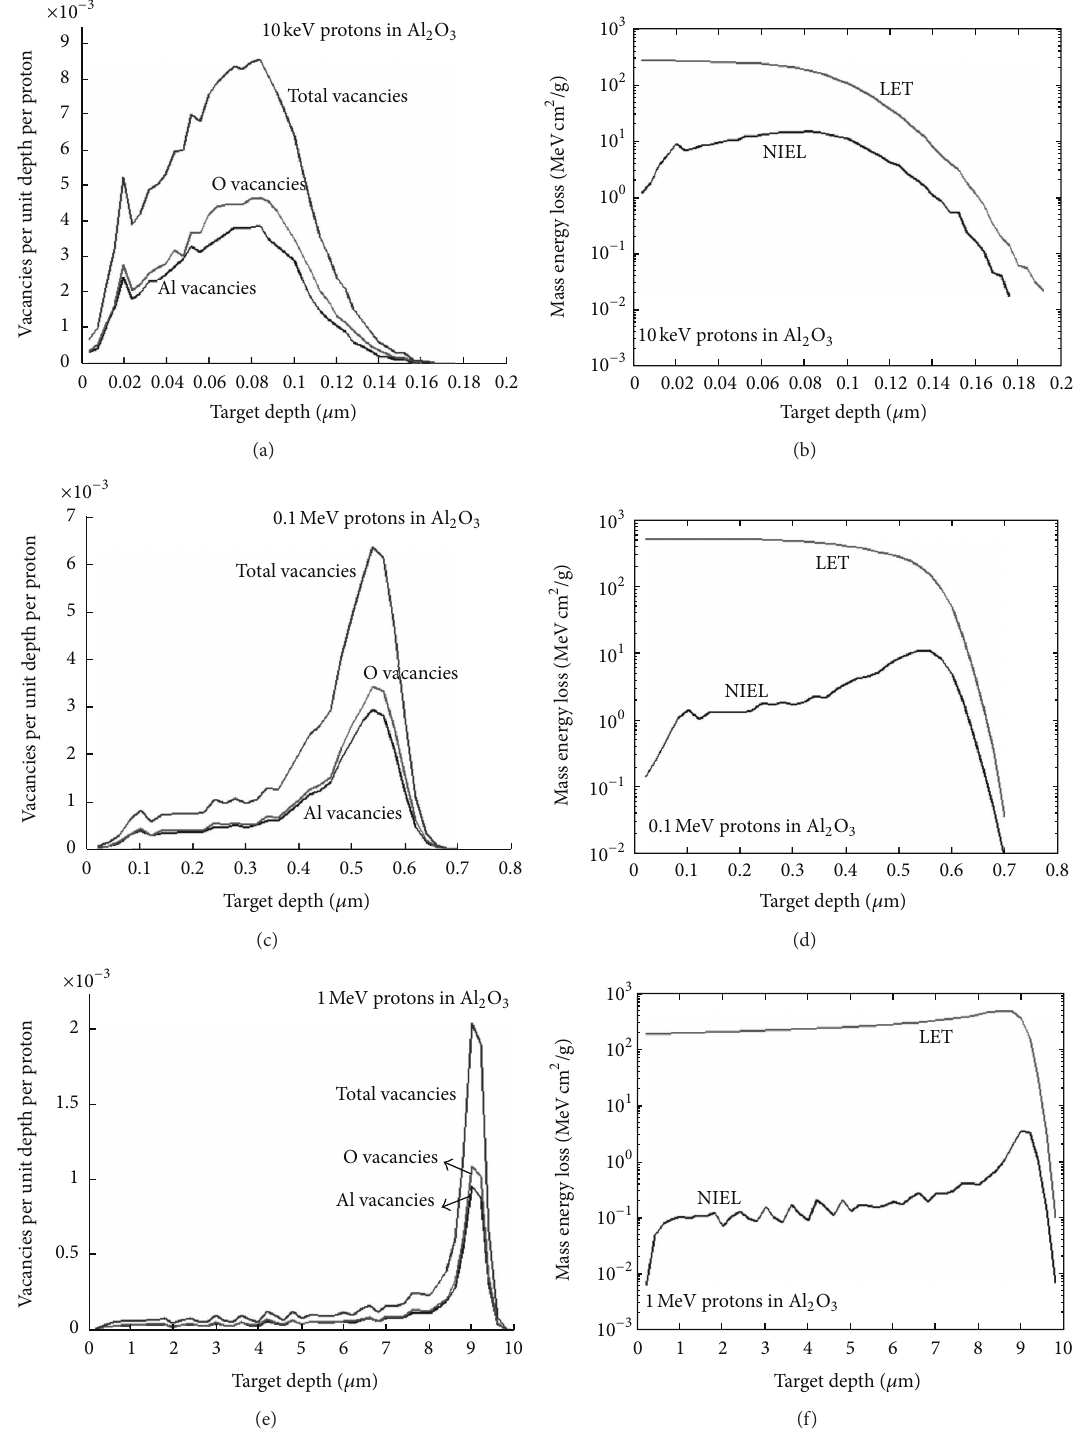
Figure 3: Plots of vacancy concentrations and mass energy losses (LET and NIEL divided by material density) along the depth of an alumina (Al 2 O 3 ) insulating film. Results were obtained from simulations of 10 4 proton histories, which included subcascades of recoiling